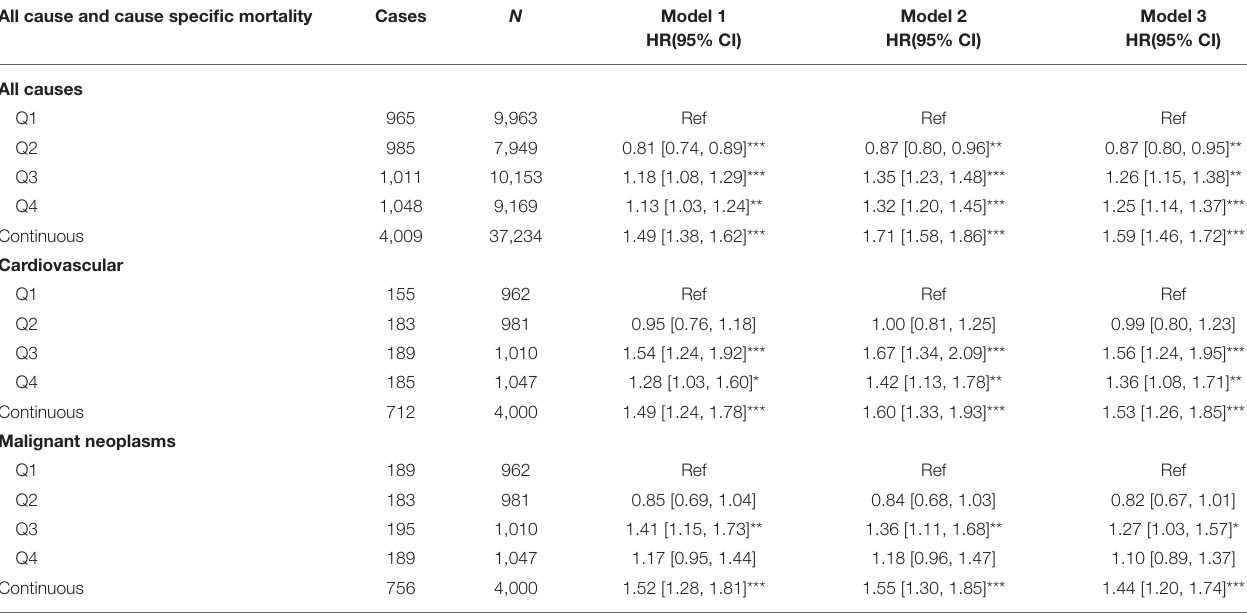
TABLE 2 | Association of total bilirubin with all-cause and cause-specific mortality. All cause and cause specific mortality